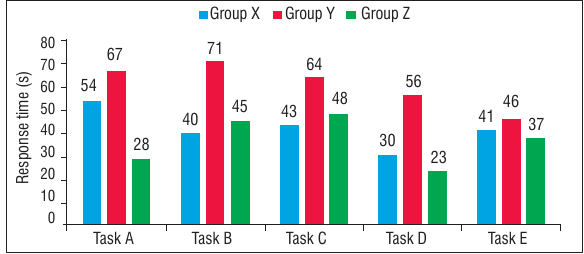
Figure 4: Average response time (in seconds) per